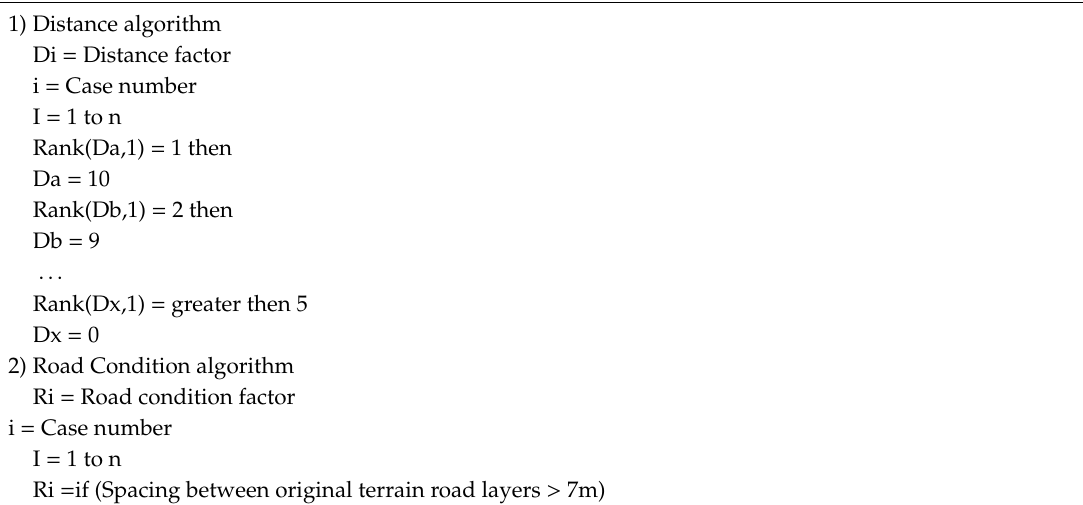
Algorithm 1 Find Optimal Path for Construction